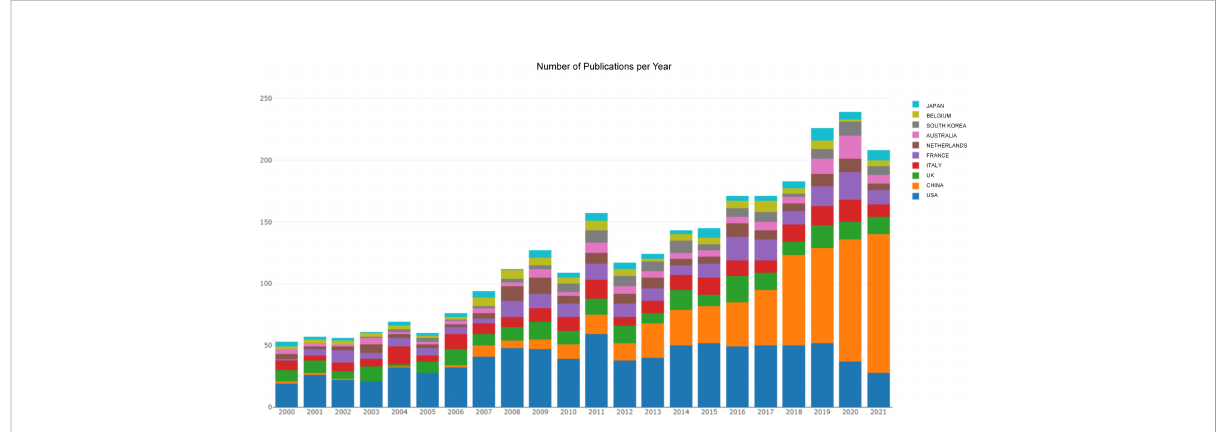
FIGURE 1 The publishing performance of countries. The yearly production trend per country in the fi eld of POI published from 2000 to